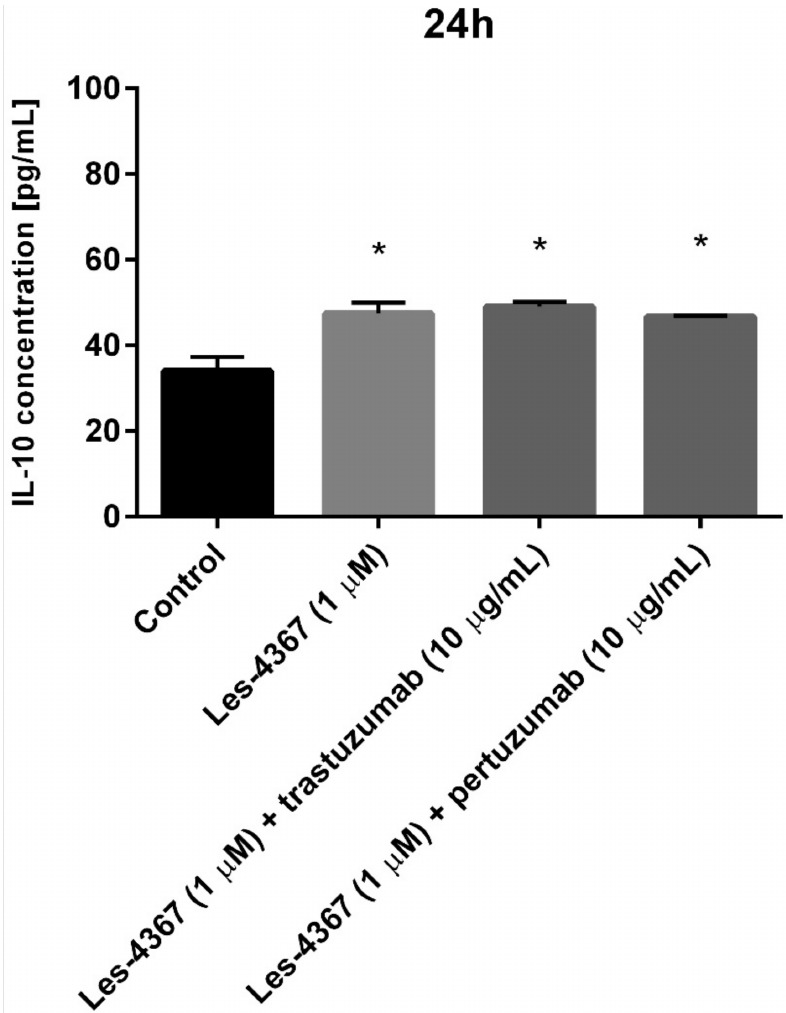
Figure 12. Concentrations of anti-inflammatory IL-10 in AGS cells after 24 h incubation with Les- 4367 (1 µ M) and combined with anti-HER2 antibodies. The ANOVA and Tukey tests were used to demonstrate differences between the control cells and the cells exposed to varying concentrations of the tested compounds. * p ≤ 0.05 vs. control